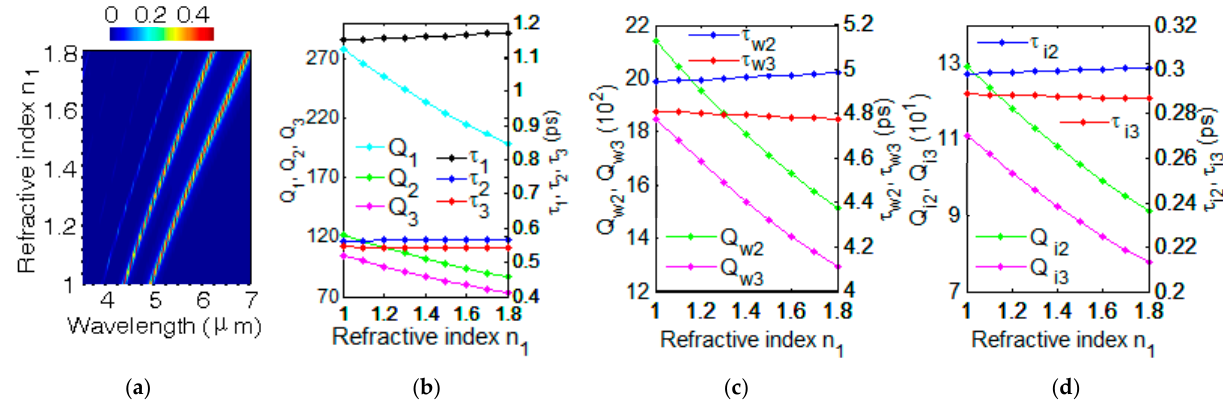
Figure 5. ( a ) The evolution of optical absorption spectra with different refractive index n 1 . ( b ) Q m (m = 1, 2, 3) with various n 1 of superstrate. ( c ) Q w2 , Q w3 and τ w2 , τ w3 with various n 1 . ( d ) Q i2 , Q i3 and τ i2 , τ i 3 with various n 1 .